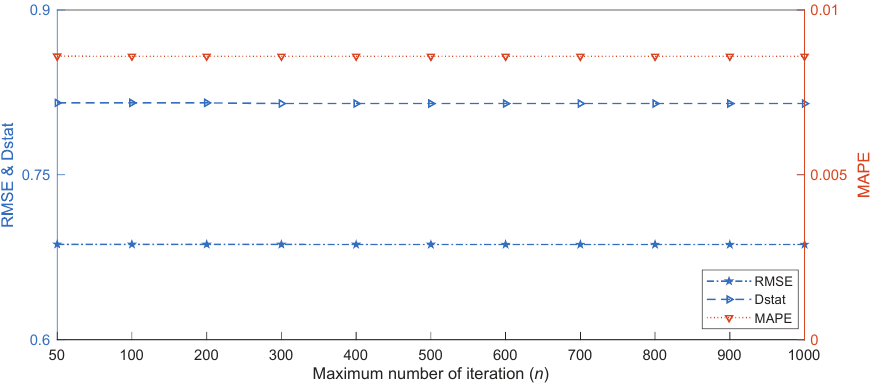
Figure 5. The impact of the variable maximum number of iteration n along with fixed λ = 0.0004 on WTI crude oil prices with one-step-ahead forecasting.